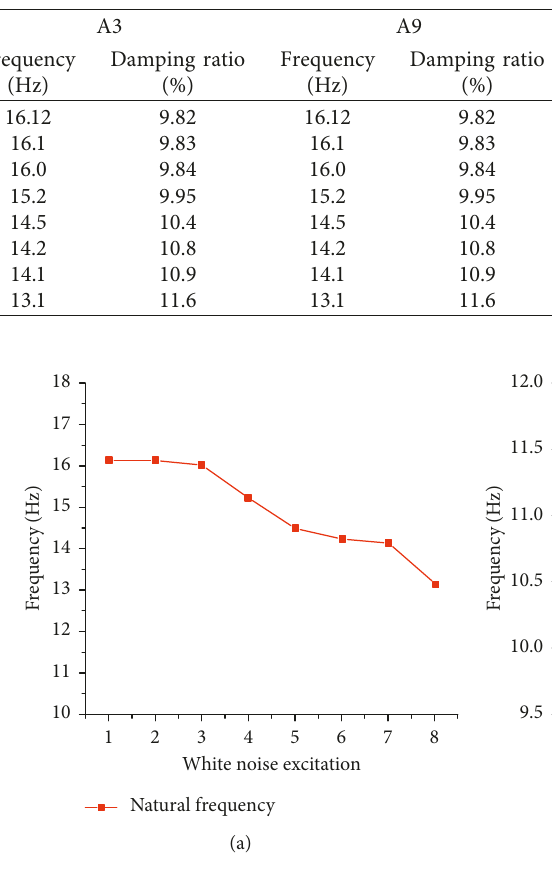
Figure 10: Variation rules of modal parameters of